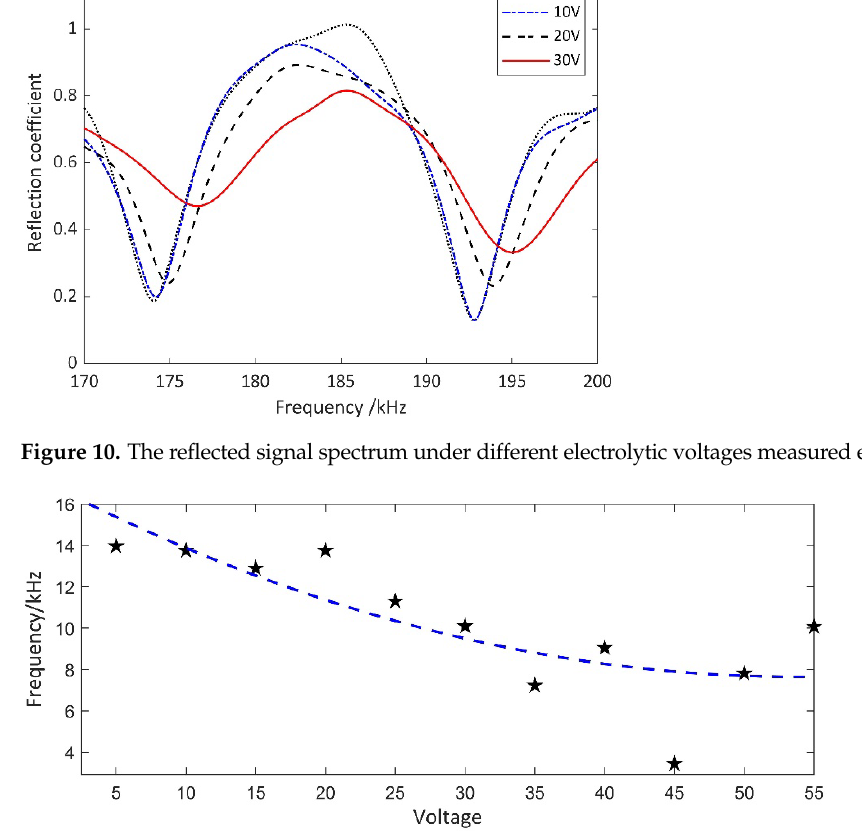
Figure 10. The reflected signal spectrum under different electrolytic voltages measured experimen- tally.